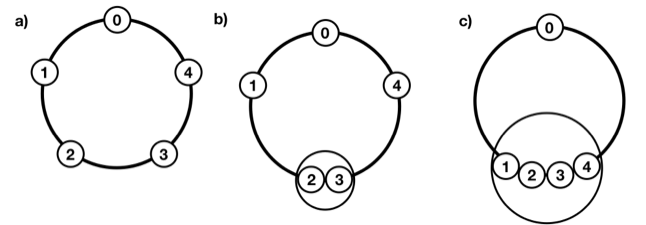
Figure 17: The extended Dynkin diagrams for breaking patterns of SU ( 5 ) : a) SU ( 5 ) , b) SU ( 4 ) , and c) SU ( 2 ) a